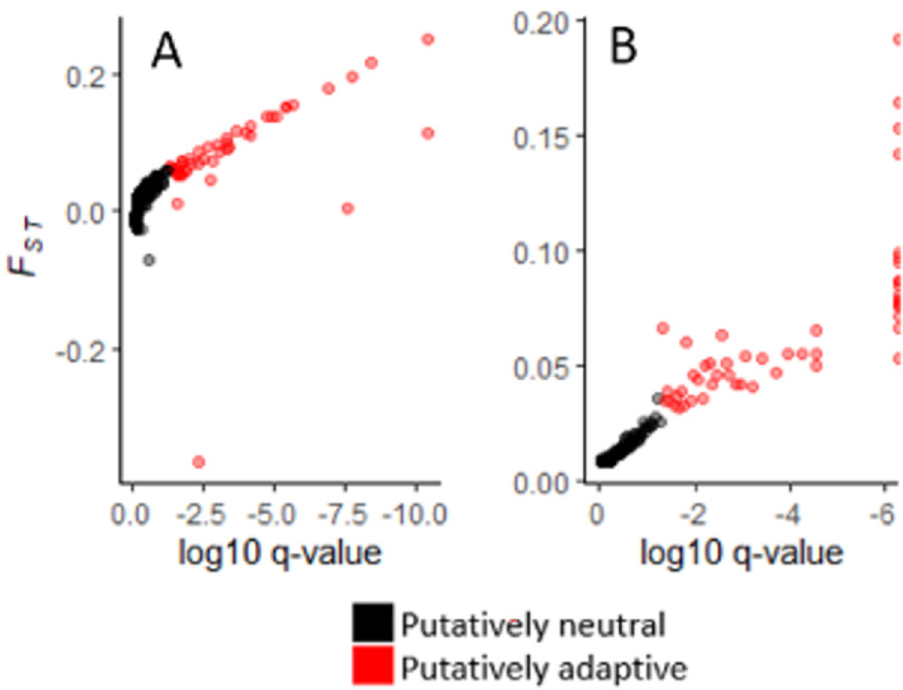
Fig 4. Results of F ST outlier detection methods. Log 10 q-value by F ST for outlier detection methods, using results generated by OutFLANK (n = 46) in panel A and BayeScan (n = 50) in panel B. Each point represents a single SNP, colored by whether it was detected as an outlier (red) or not (black).